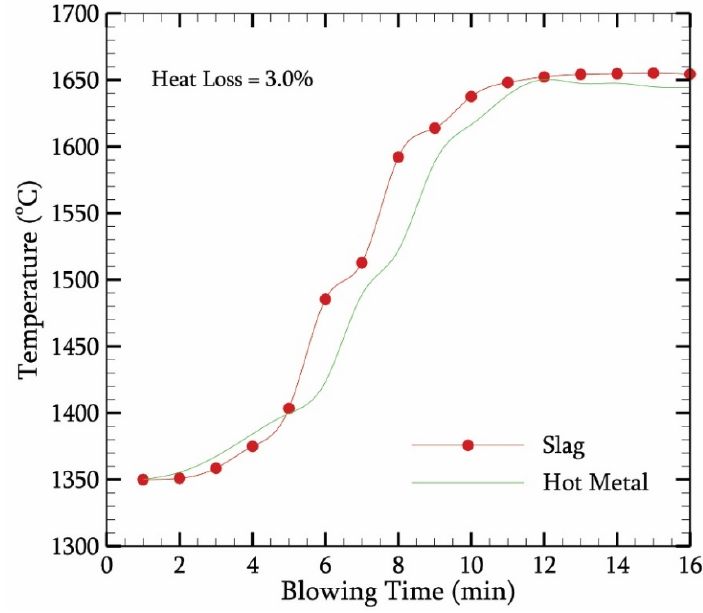
Figure 7. Slag and hot metal temperature profiles for a heat loss of 3%.